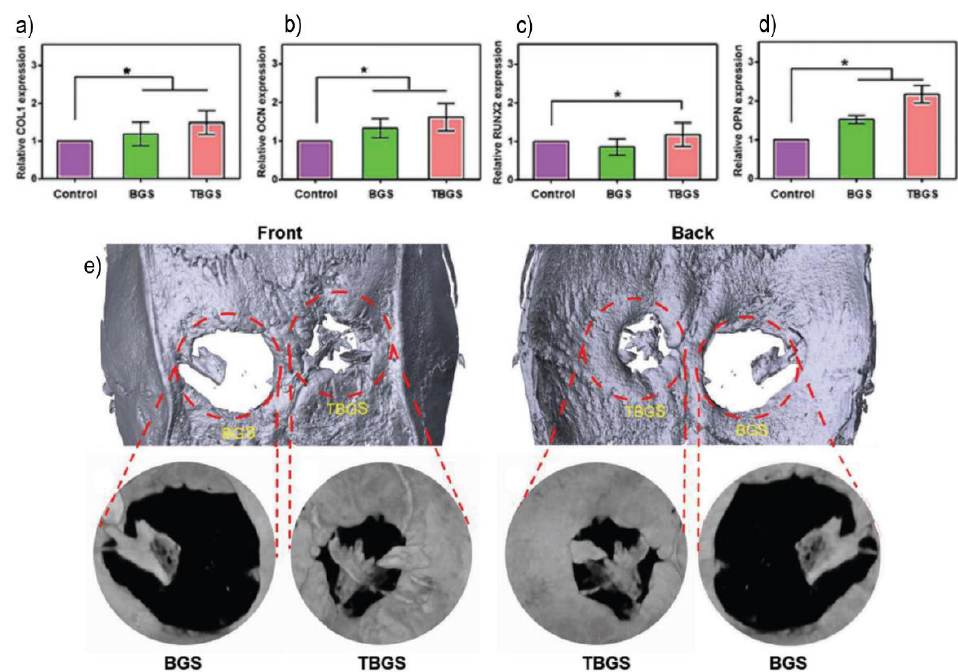
Figure 5. Osteogenic gene expression of ( a ) COL-1; ( b ) OCN; ( c ) RUNX2; ( d ) OPN in control, bioglass scaffolds (BGS) and BG/Ti 3 C 2 scaffolds (TBGS). * represents a p < 0.05 significance. ( e ) in vivo osteogenic performance of BGS and TBGS scaffolds at 24 w post-scaffold implantation. Adapted from [92] © 2019 The Authors. Published by WILEY-VCH Verlag GmbH & Co. KGaA, Weinheim.